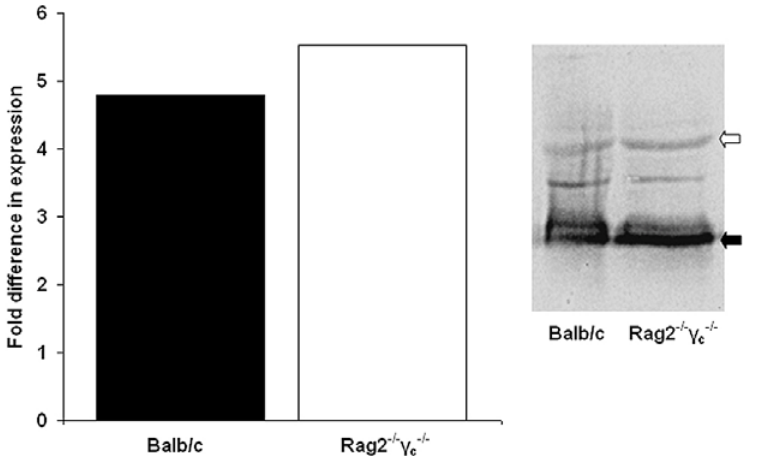
Figure 6. HASPB RNA and protein abundance in L.major amastigotes isolated from BALB/c and Rag2 2 / 2 c c 2 / 2 mice. Amastigotes isolated from the livers of two mice of each strain (BALB/c and Rag2 2 / 2 c c 2 / 2 mice), 4 weeks post-infection with L. major (see Figure 5), were used for RNA and protein extraction, as described. HASPB expression was analysed by (A) RT-qPCR for RNA and (B) immunoblotting with anti-HASPB for protein ( L. major HASPB migrates at 38.5 kDa (black arrow); NMT, at 50 kDa (white arrow)). NMT was used as a constitutive control for both RNA and protein expression levels.